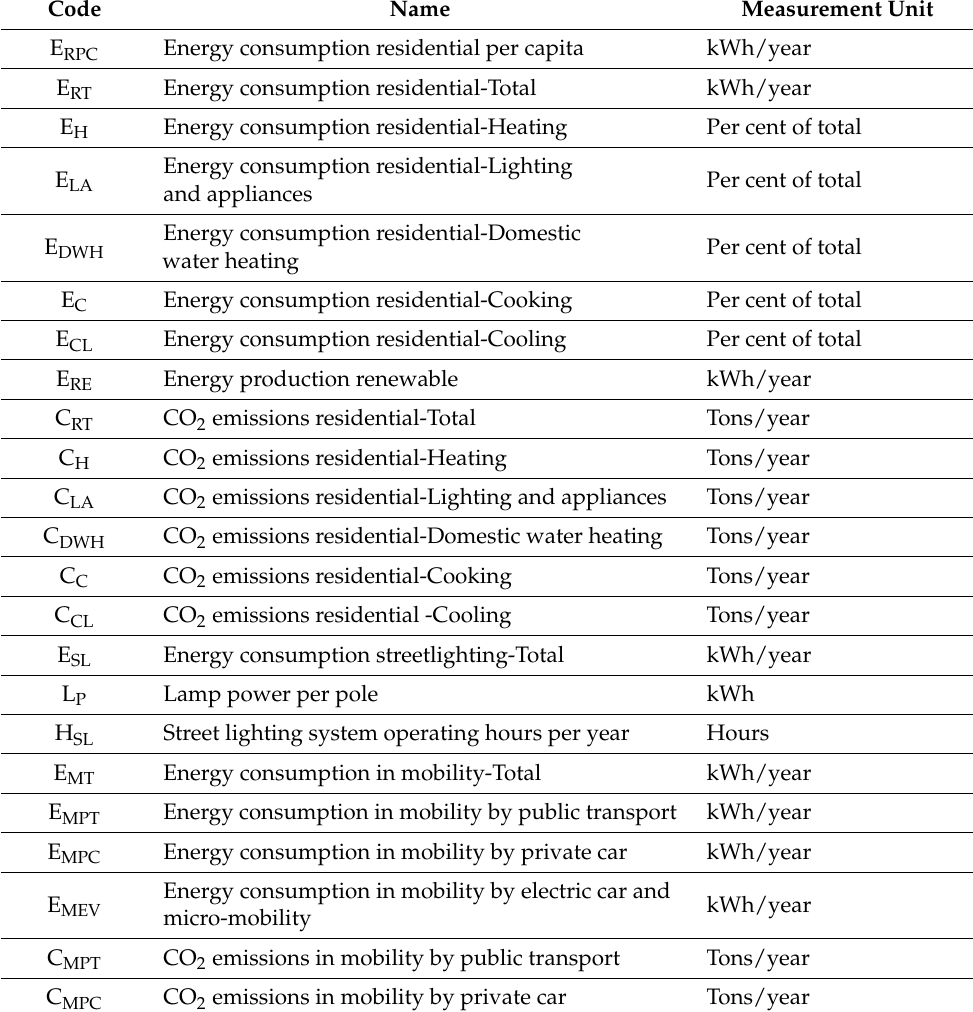
Table 3. Key variables and metrics energy usage and CO 2 in residential districts.